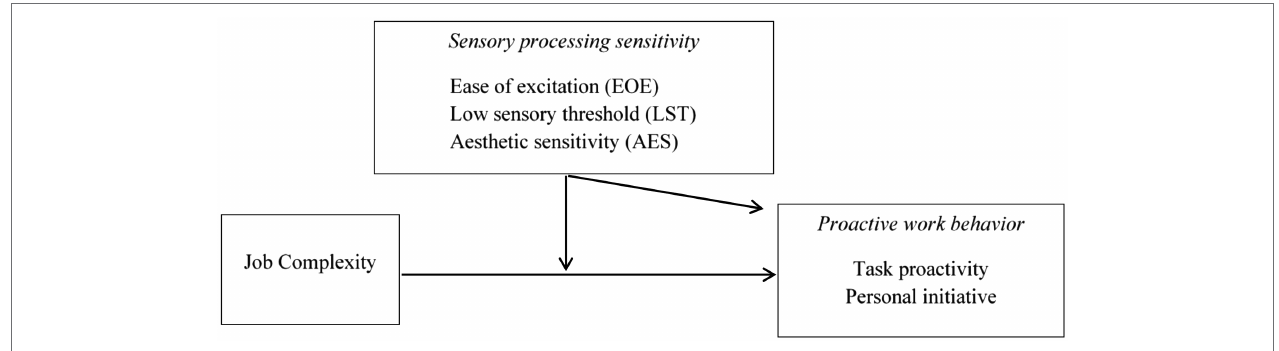
FIGURE 1 | Conceptual